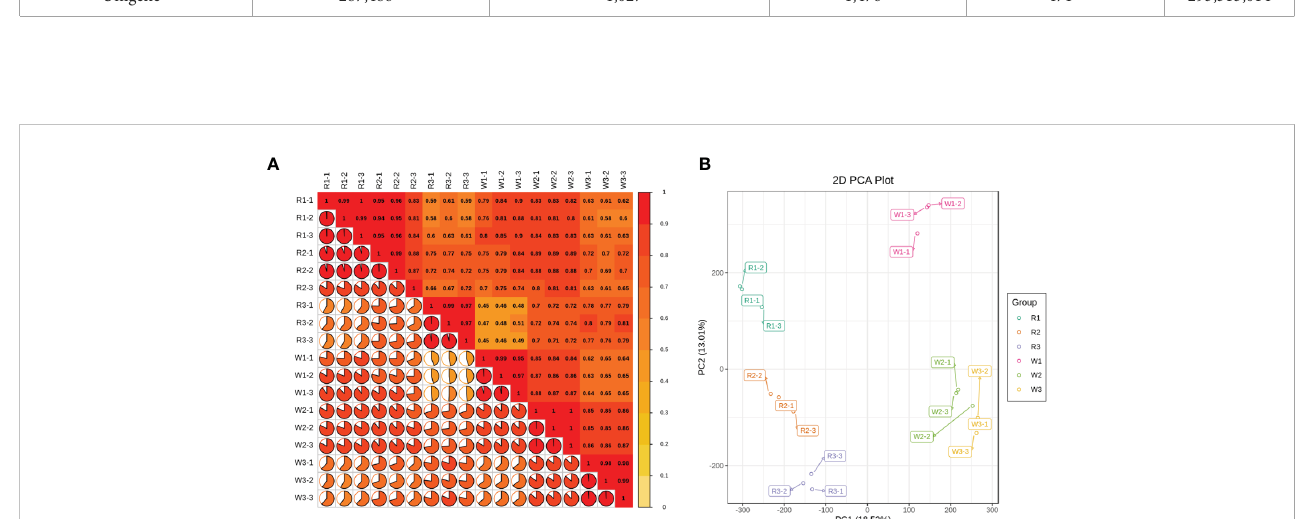
FIGURE 1 (A) Sample-to-sample correlation analysis between each nut fl ower at different developmental stages. The numbers in the box represent the correlation coef fi cient between each sample; more depth of the color bar on the right indicates a higher correlation. The pie chart and the color of each sample represent the proportions of the correlation coef fi cients. (B) Principal component analysis (PCA) for each group of nut fl owers. R1 , R2 , and R3 represent the three stages of red Macadamia integrifolia fl owers, while W1 , W2 , and W3 represent the three stages of white M. integrifolia fl owers. Each color and developmental stage of the nut fl ower samples had three biological repeats, denoted as -1 , -2 , and -3